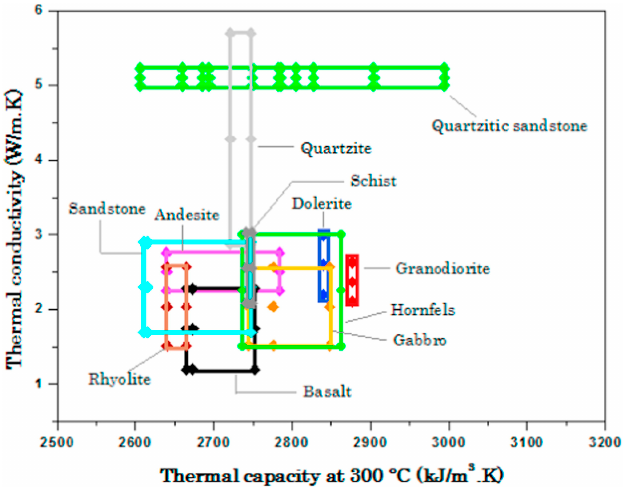
Figure 2. Thermal conductivity and thermal capacity of studied earth materials for CSP plants. Reprinted with permission [90]; 2017, Elsevier.